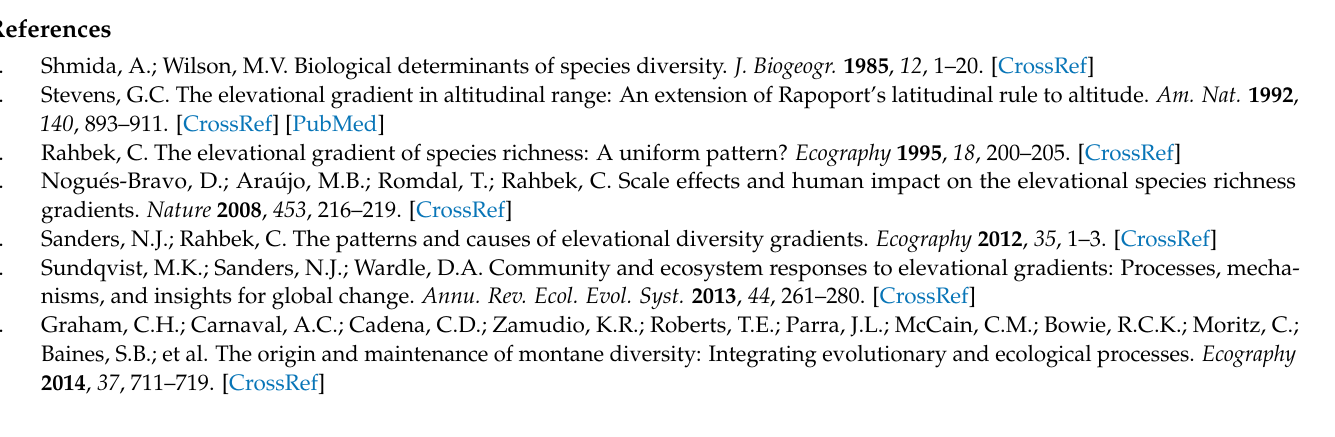
Table S2. Best fitting multiple and single factor model for each plant growth forms of elevational species richness pattern. The factors showing the best performance in each hypothesis group were selected as the best candidate factor combination; Adjusted R-squared are given for the best models remove collinearity; Table S3: Pearson correlation coefficients of all candidate factors for model selection of each elevational species richness